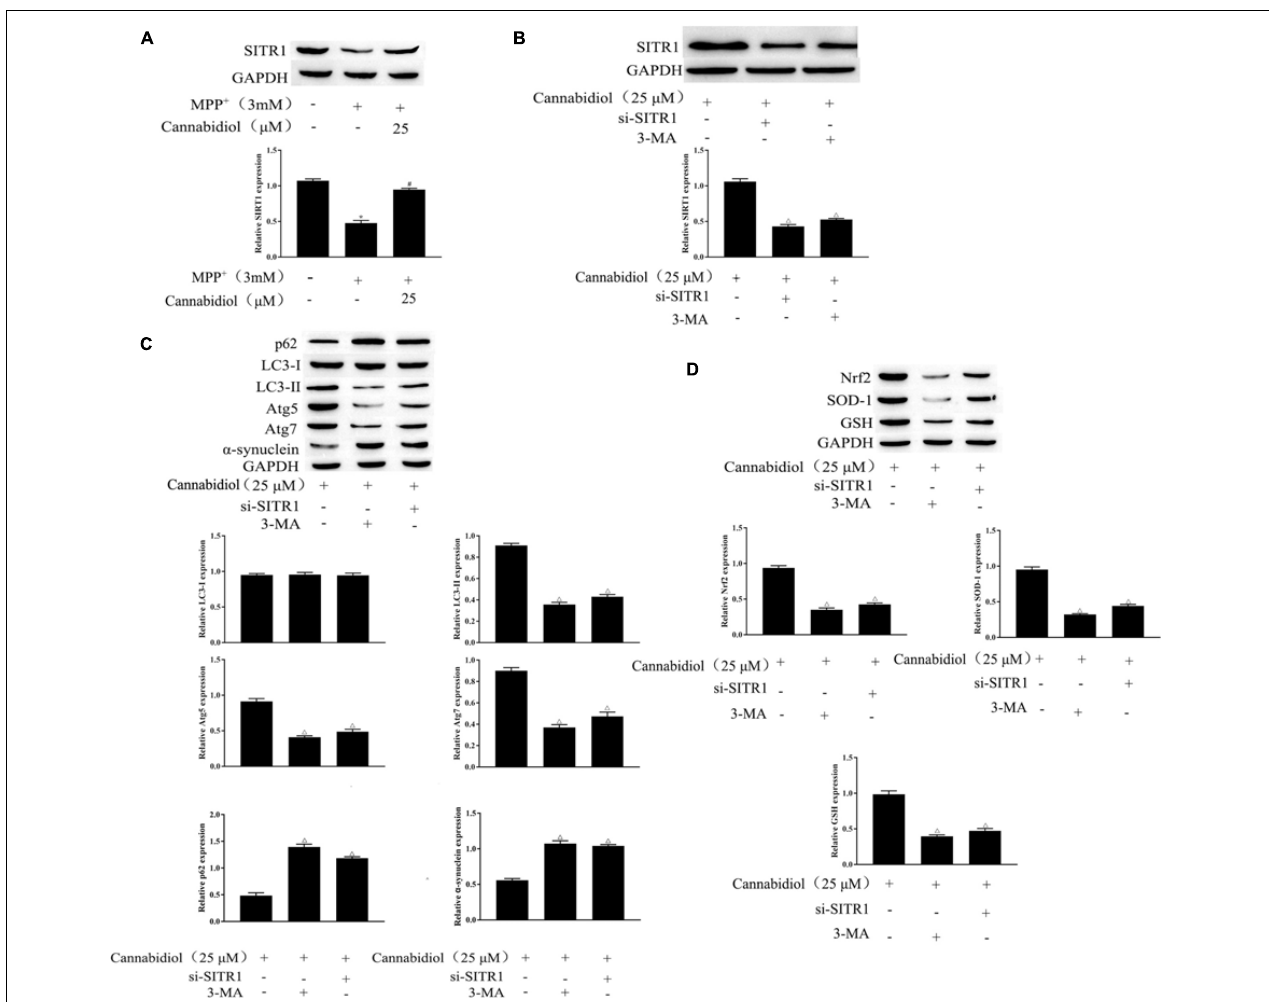
FIGURE 4 | Blockade of autophagy and knockdown of SIRT1 attenuated the alleviation effect of Cannabidiol on the dysfunction of mitochondrial induced by MPP + . (A,B) The expression of SIRT1 in Cannabidiol treatment SH-SY5Y cells were measured by western blotting; (C,D) The expression of autophagy-related proteins and antioxidant proteins in SH-SY5Y cells were measured by western blotting; * p < 0.05, compared with control group, # p < 0.05 compared with MPP + alone, (cid:77) p < 0.05 compared with Cannabidiol